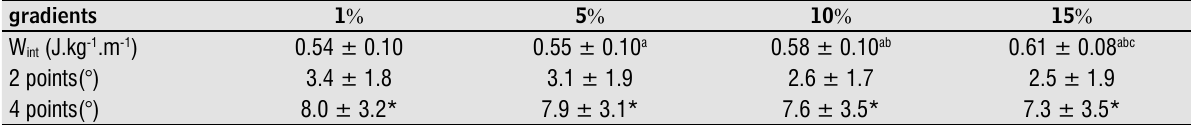
Table 1 – Mean and standard deviation (SD) values of the variables internal mechanical work (W pronation calculated with two and four anatomical reference points, at different gradients, of 16 trained male long-distance